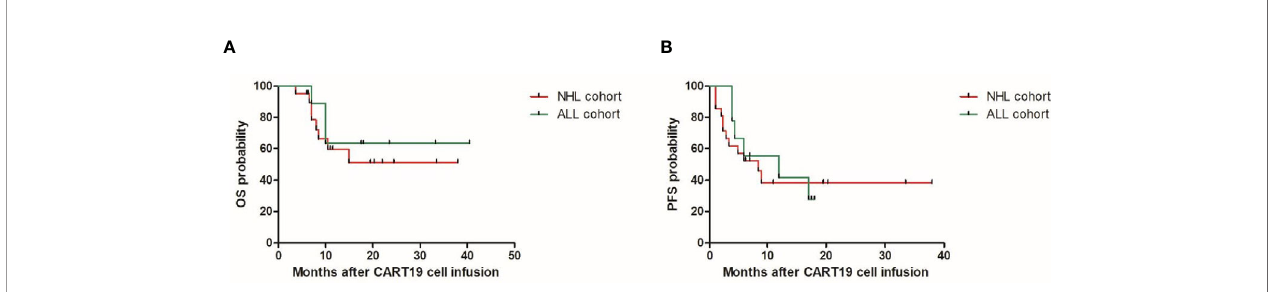
FIGURE 1 | Overall survival (OS) (A) and progression free survival (PFS) (B) in the patients with resolved HBV infection after CAR-T cell therapy. ALL, acute lymphoblastic leukemia;